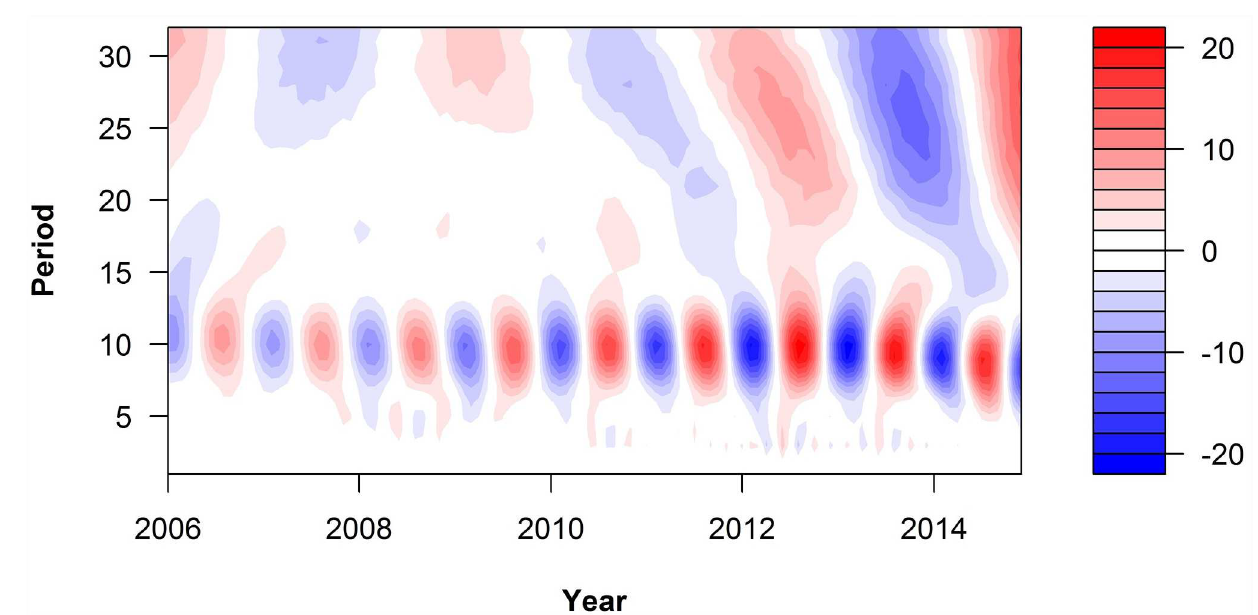
Fig 3. The evolution of the periodic components of scrub typhus over